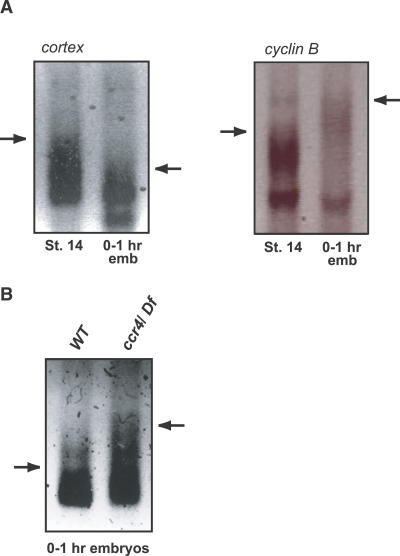

cort mRNA Is Deadenylated in Early Embryos(A) PAT assays showing shortening of poly(A) tail length of cortex mRNA and elongation of poly(A) tail length of cyclin B mRNA in wild-type stage 14 oocytes and 0–1-h embryos. Arrows indicate the top of each poly(A) smear.(B) Deadenylation of cort mRNA requires ccr4. PAT assay showing elongation of poly(A) tail length of cortex mRNA in 0–1-h embryos from ccr4/Df mutant mothers compared to wild-type control embryos. Arrows indicate the top of each poly(A) smear.